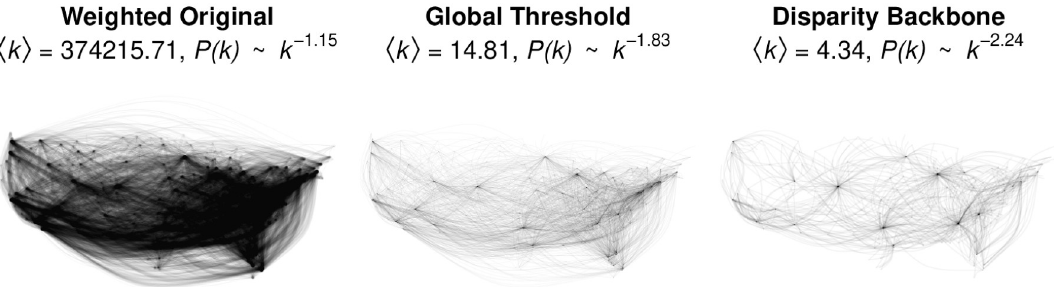
Fig 3. Extracting the backbone of a weighted network of continental US airline traffic in 2019.